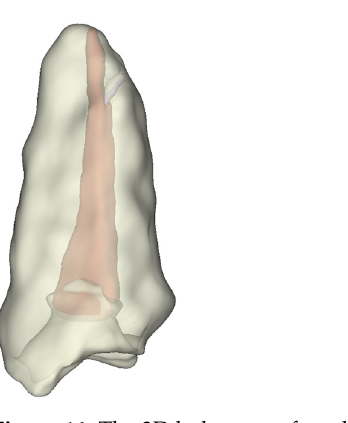
Figure 14. The 3D hologram of tooth 11, subjected to endodontic treatment. Table 5. The minimum number of scans for each root canal is needed to analyze its entire course and the percentage of the length of the canal visible on the scan, in the case of the treatment of tooth 11. The Number of Shots Needed to Type of Root Canal Visualize/Evaluate the Entire Root Canal